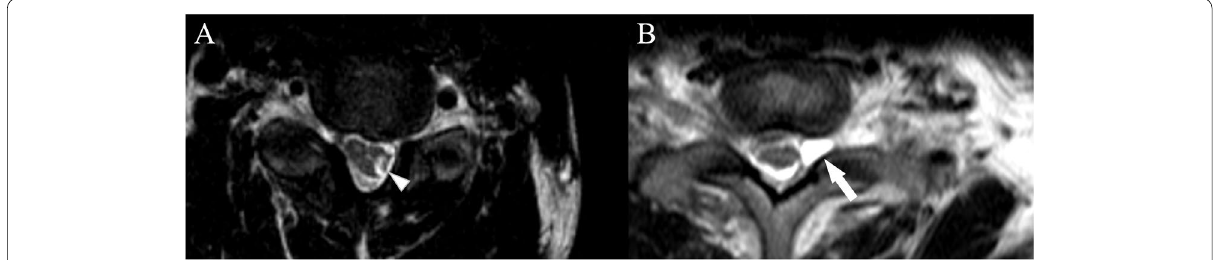
Fig. 1 Cervical spine axial T2-weighted magnetic resonance image. A High-intensity lesion on the left spinal cord at the level of C5/6 (white arrowhead). B High-intensity lesions of C 7/Th1 level intervertebral foramen, considered to be a pseudomeningocele (white